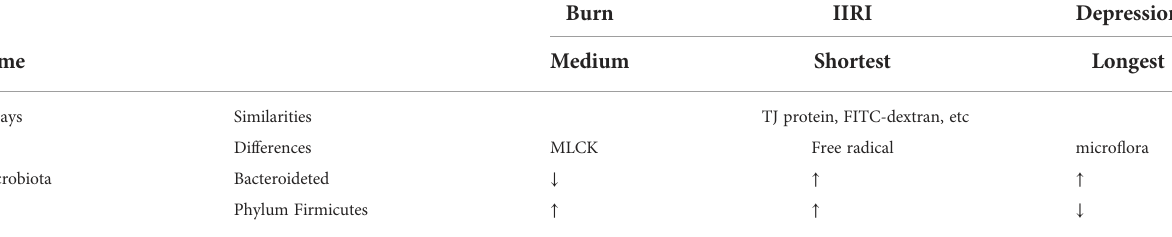
TABLE 1 Difference between intestinal mucosal barrier injury and intestinal microecological imbalance caused by burning, IIRI, and